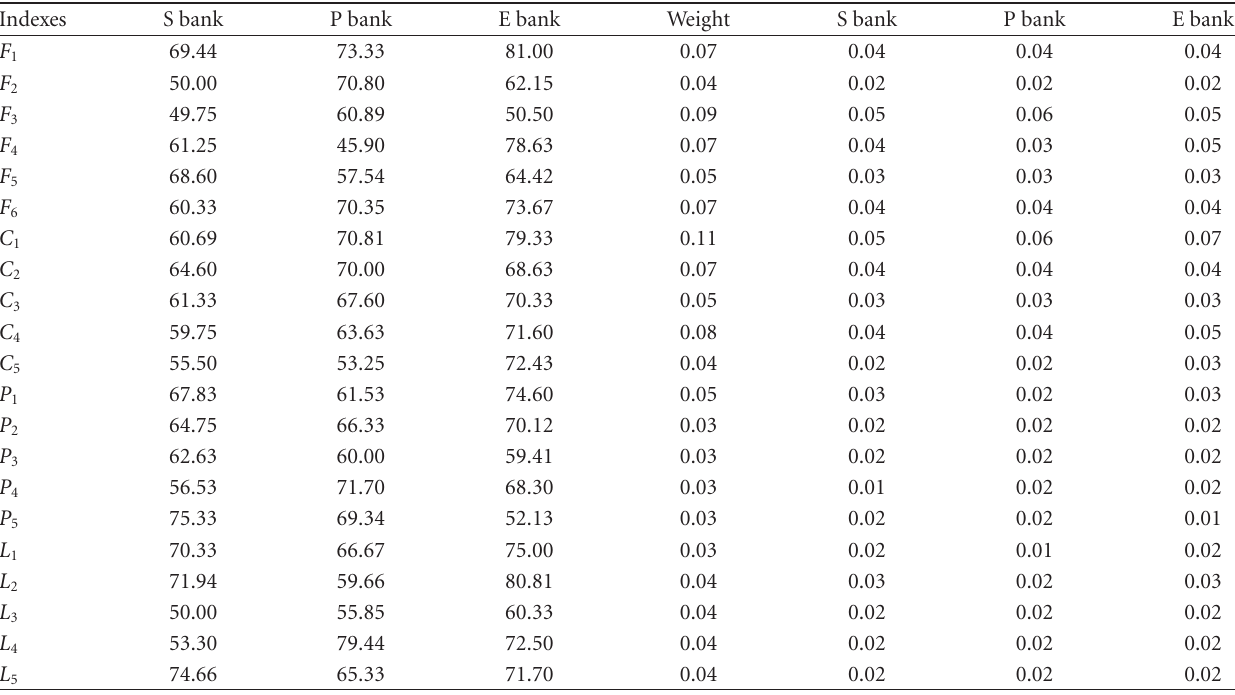
Table 9: Normalized data of indexes based on ELECTRE method.